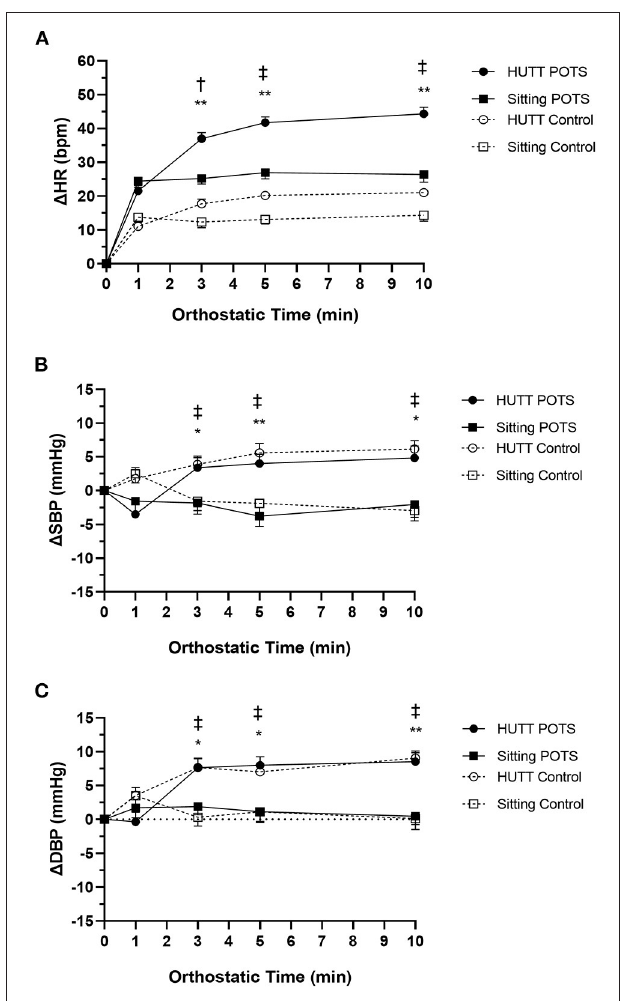
FIGURE 1 | Hemodynamic responses for the postural tachycardia syndrome (POTS) and control groups during the sitting test and the head-up tilt test (HUTT). (A) Change in heart rate ( 1 HR). (B) Change in systolic blood pressure ( 1 SBP). (C) Change in diastolic blood pressure ( 1 DBP) from supine (0) to sitting or tilting 10min. Data are the mean ± standard error. * p < 0.05, ** p < 0.01 indicate significant difference between the sitting test and the HUTT in the POTS group. † P < 0.05, ‡ P < 0.01 indicate significant difference between the sitting test and the HUTT in the control